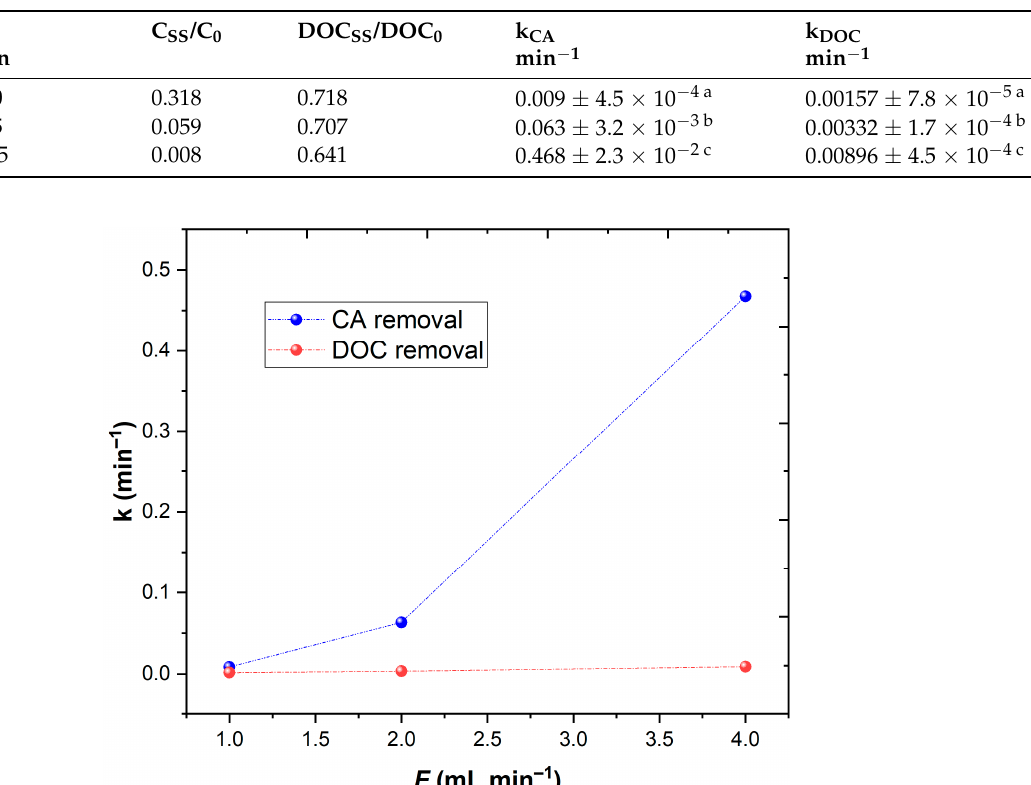
Figure 8. Assessment of different flow rates (1–4 mL min − 1 ) in ( a ) CA and DOC removal; ( b ) H 2 O 2 and Fe 2+ concentration available as function of θ . Operational conditions: [CA] = 5.5 × 10 − 4 mol L − 1 , [Fe 2+ ] = 1.1 × 10 − 4 mol L − 1 , pH = 3.0, agitation 150 rpm, temperature = 298 K, radiation UV-A, I UV = 32.7 W m − 2 , HRT = 15 min.